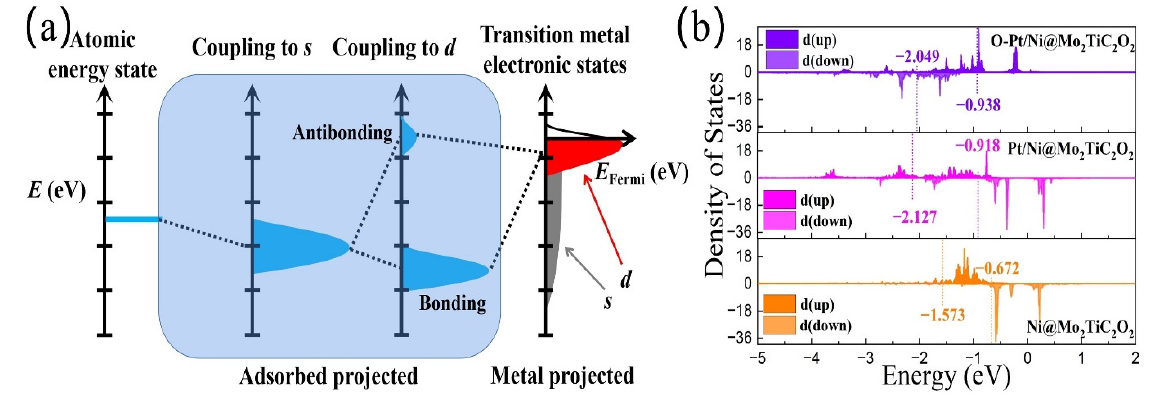
Figure 5. ( a ) The schematic diagram of d-band center theory mechanism. ( b ) The projected DOS and the position of d-band center of Ni atom for Ni@Mo 2 TiC 2 O 2 , Pt/Ni@Mo 2 TiC 2 O 2 , and O-Pt/Ni@Mo 2 TiC 2 O 2 . The position of d-band center of spin-up and spin-down are marked with numbers, respectively.